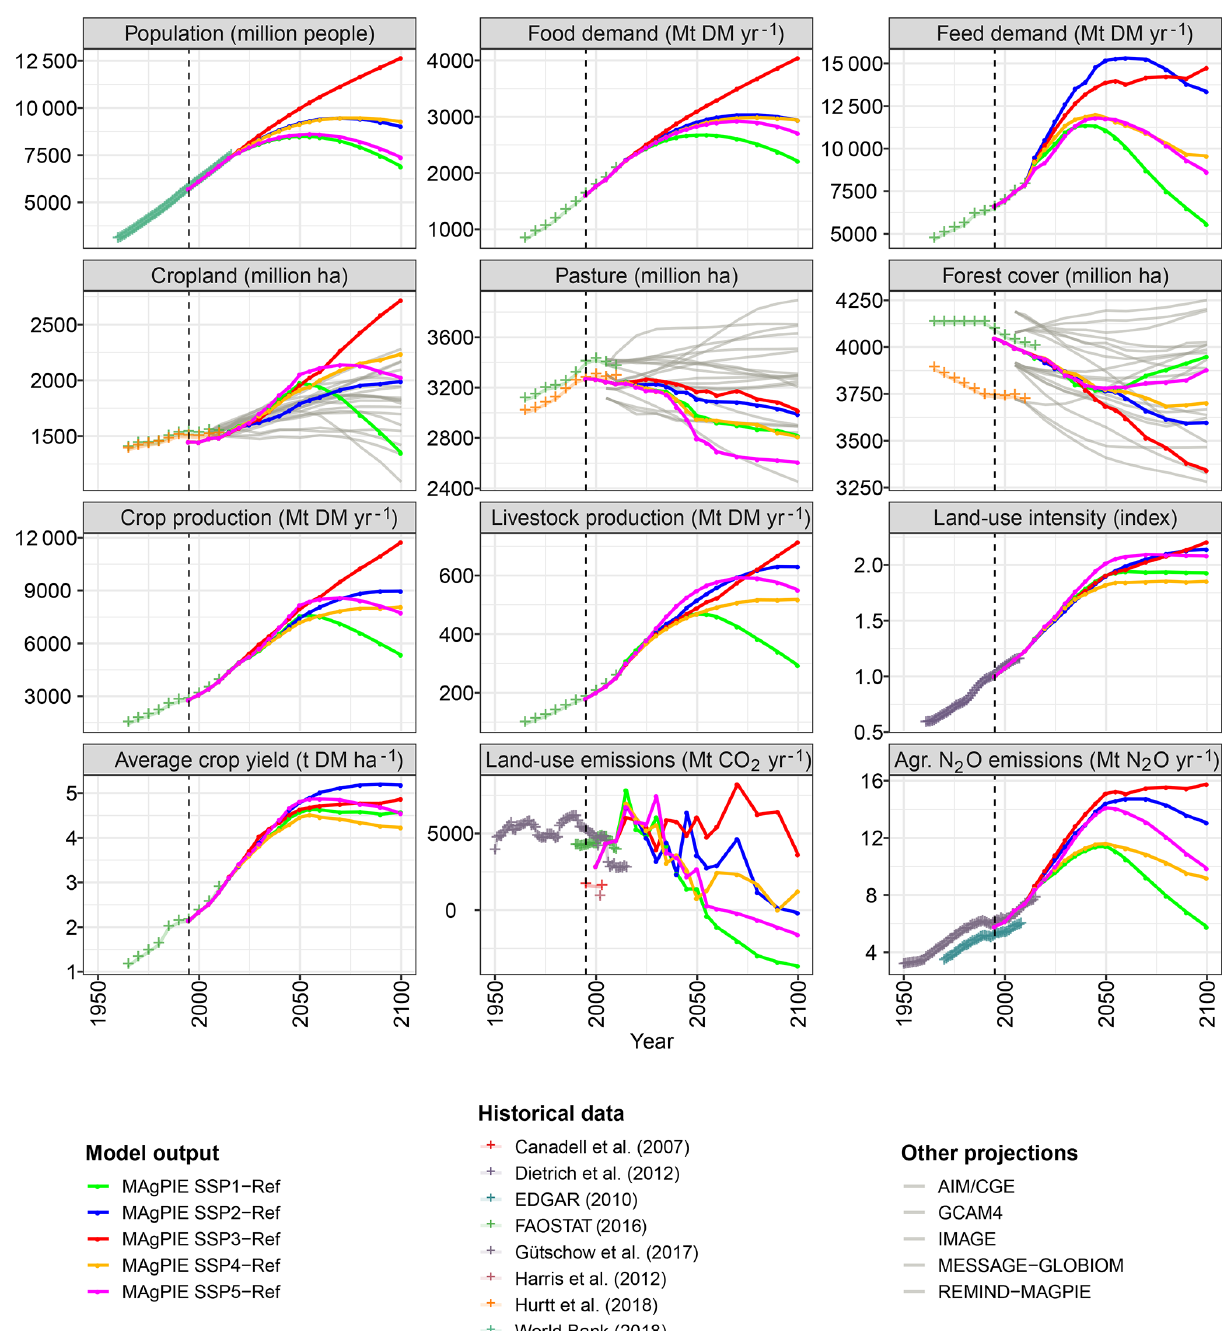
Figure B1. Evaluation plots for MAgPIE 4 inputs and outputs for SSP 1–5 reference scenarios at global level. Sources of historical data: Canadell et al. (2007), Dietrich et al. (2012), EDGAR (2010), FAOSTAT (2016); Harris et al. (2012), Hurtt et al. (2019), Gütschow et al. (2017) and World Bank (2018). Sources of other projections for SSP 1–5 reference scenarios: IAMC (2016).